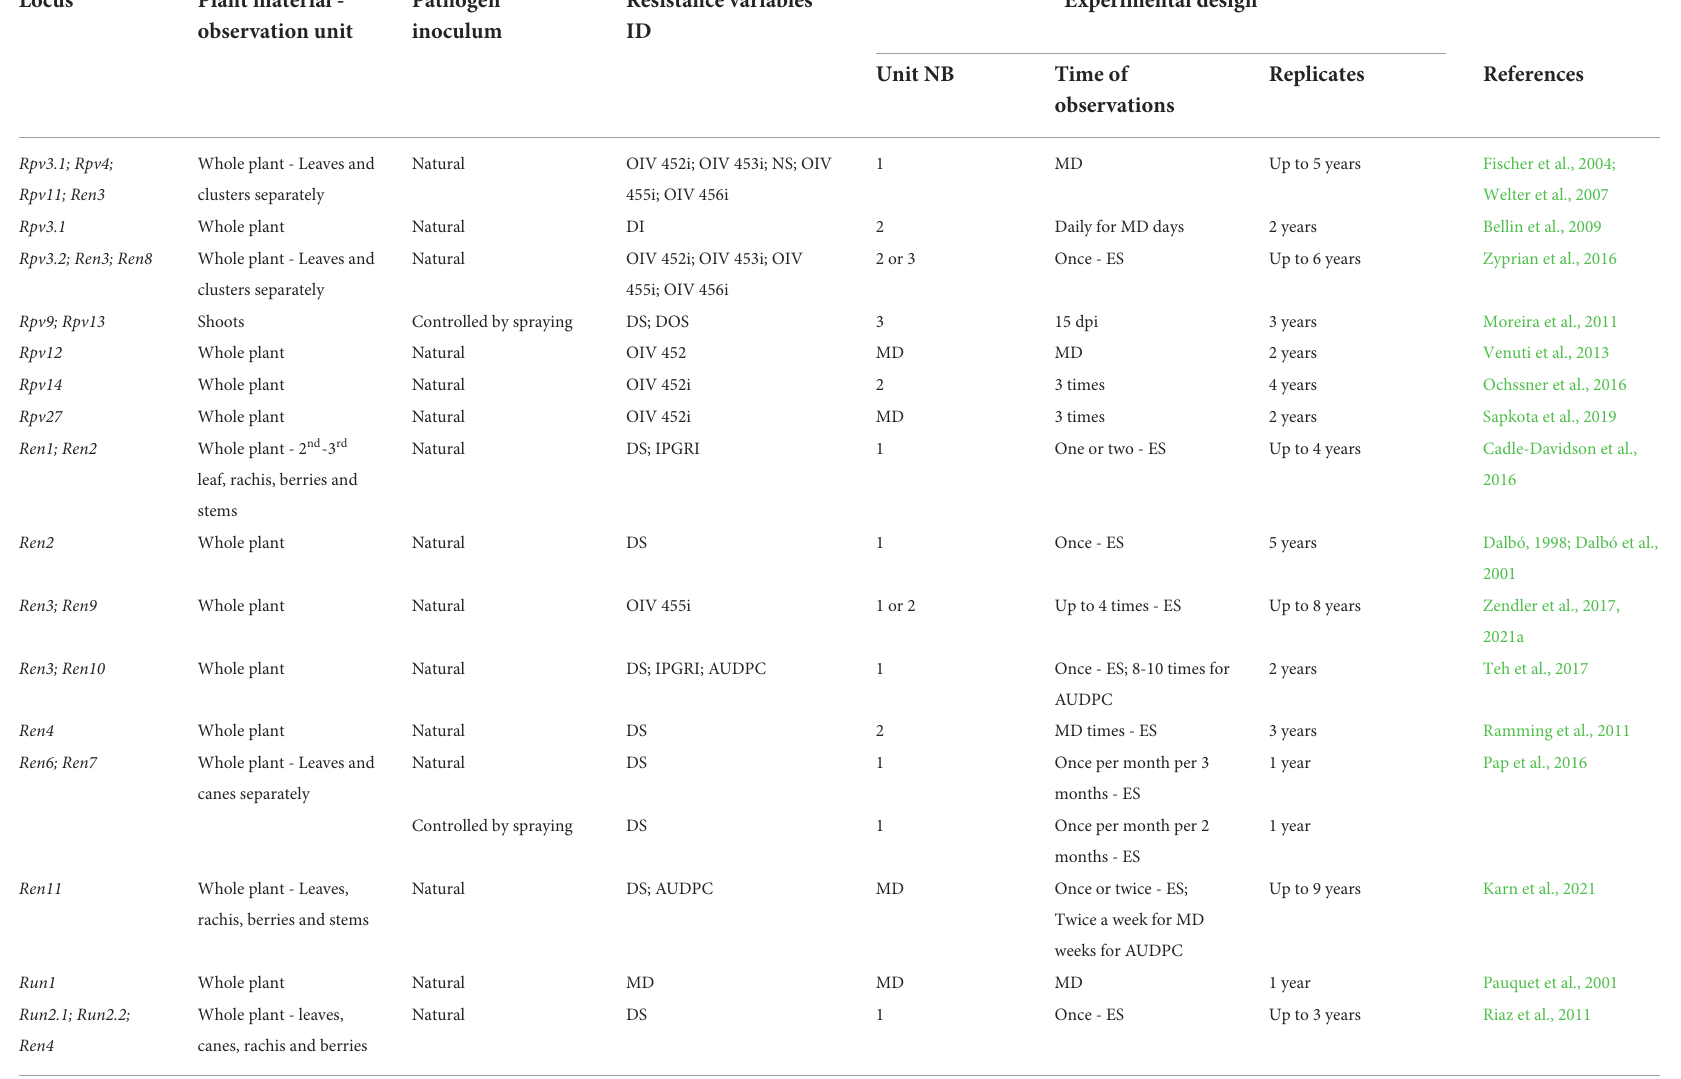
TABLE 4 Resistance phenotyping strategies utilized in the vineyard. The main elements and possible sources of variation of phenotyping protocols adopted in the main mapping studies are reported for each Rpv and Ren/Run locus.